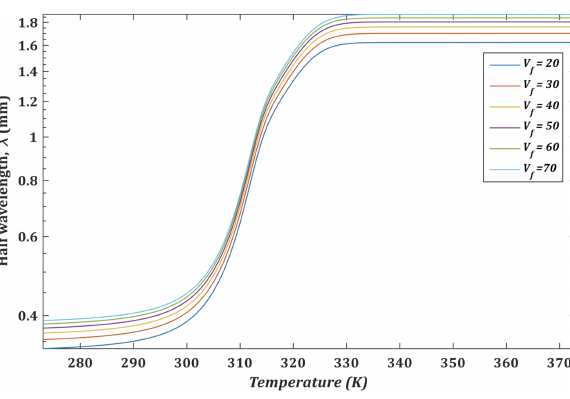
Figure 14: Variation of the half wavelength ( λ ) with respect to thick- ness ( t ) at T = T β , T g and T f